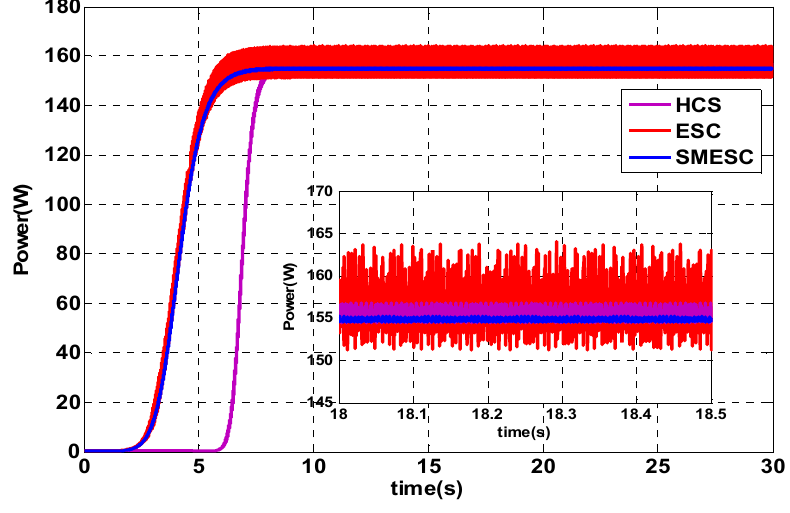
Figure 10. HCS, ESC, SMESC dynamic response comparison